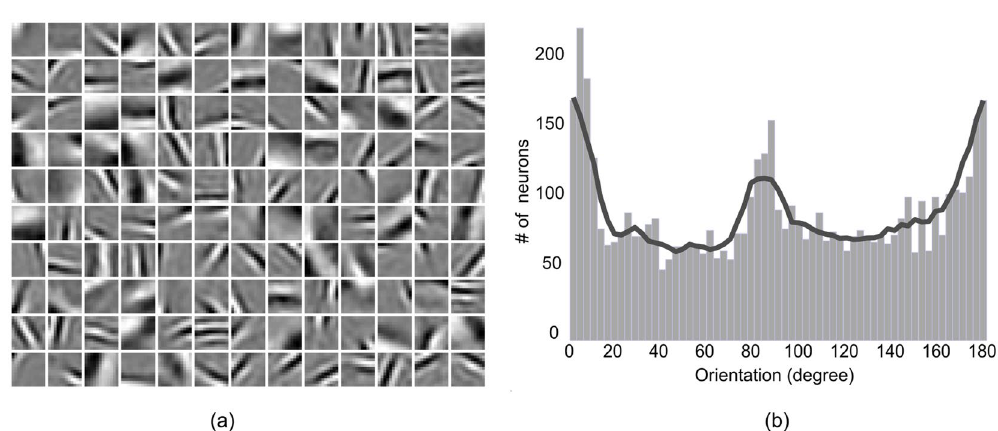
Figure 2. Anisotropy in orientation selectivity. ( a ) Learned weighting profiles of 130 neurons at one of the 9 modules at level 1 after a single training. ( b ) Orientation distribution at level 1 for all the neurons (130 × 9). The envelope (continuous line) is obtained by averaging over 7 bins of the